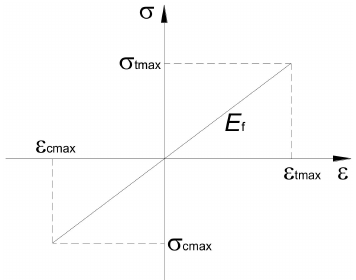
Figure 4. Material parameters for Elastic Material model.